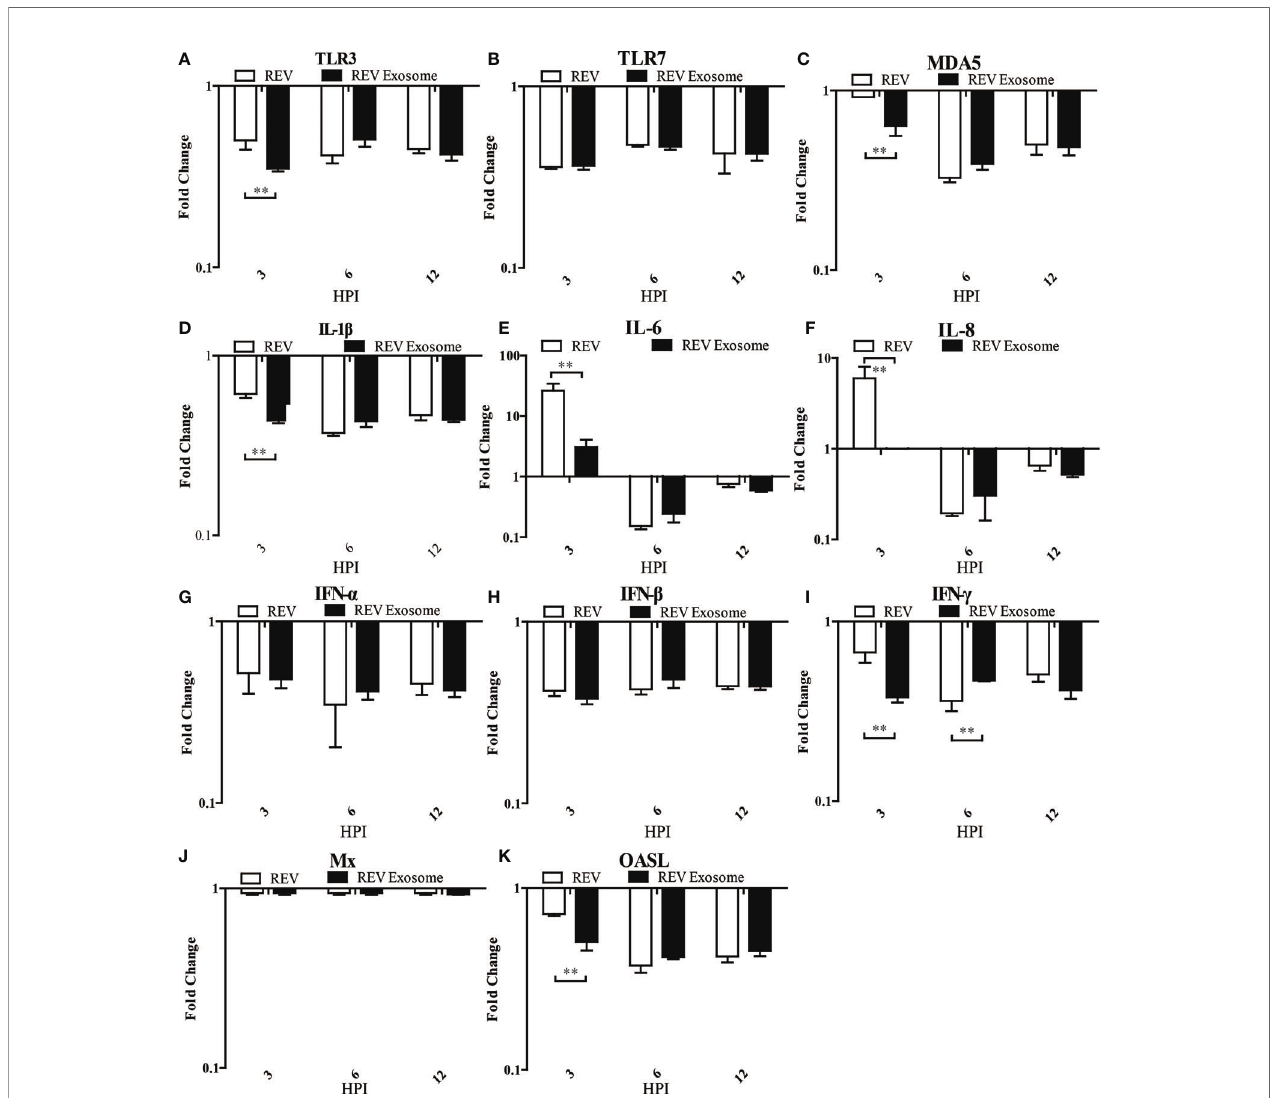
FIGURE 6 | Expression pro fi les of immune-related genes in infected CEF. Cells were infected with equal REV or REV exosome and then collected at 3, 6, and 12 hpi. The inducible gene expression levels in the cells were tested using real-time quantitative reverse transcription polymerase chain reaction analysis. Fold change was calculated by comparing the experimental group with controls at the same sampling point, and relative expression levels were normalized to the b -actin gene and calculated using the 2 − △△ Ct method. Data are the means across three independent experiments, and each experiment was analyzed in triplicate. Results are expressed as means ± SDs ( n = 3). **Indicates signi fi cant difference ( p < 0.01) between the two experimental groups. (A – K) Expression levels of TLR3, TLR7, MDA5, IL-1 b , IL-6, IL-8, IFN- a , IFN- b , IFN- g , OASL, and Mx in